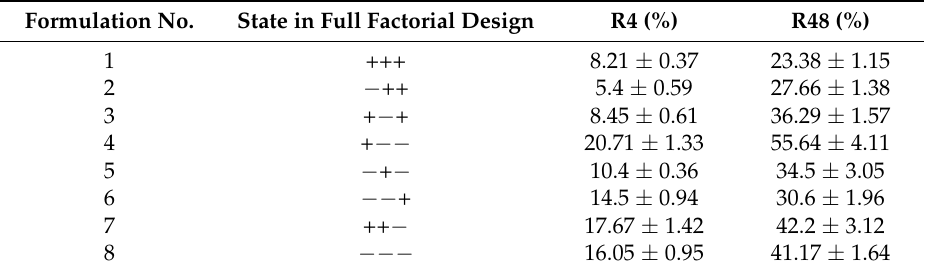
Table 3. Different parameters regarding drug release from lipid nanoparticles (mean ± SD, n = 3). R4% and R48%: percentage of drug releaseed after 4 and 48